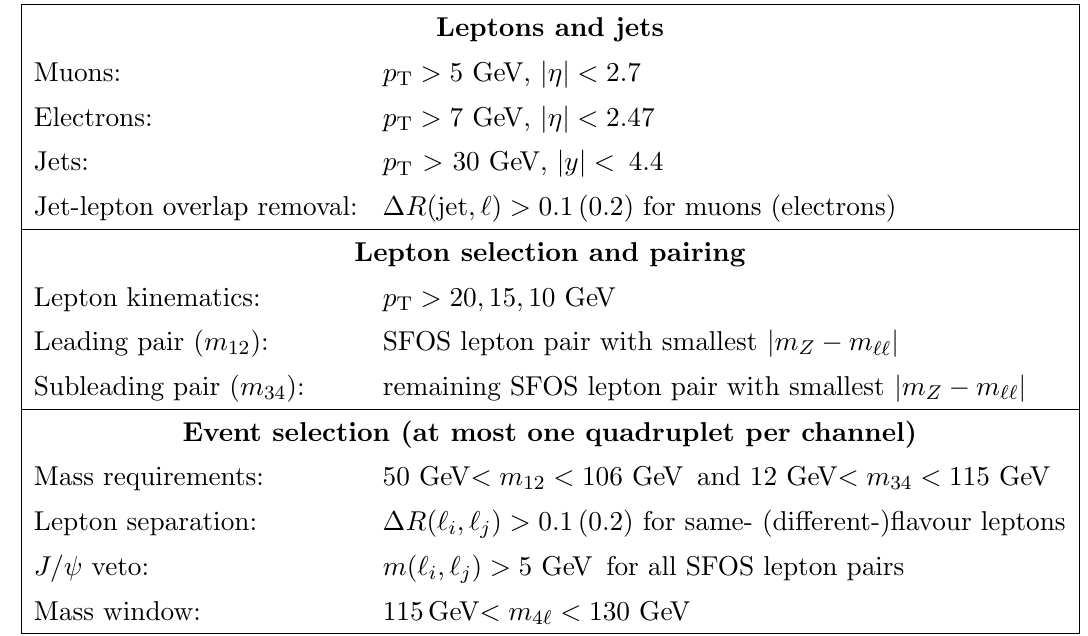
Table 1. List of event selection requirements which de(cid:12)ne the (cid:12)ducial phase space of the cross- section measurement. SFOS lepton pairs are same-(cid:13)avour opposite-sign lepton pairs.